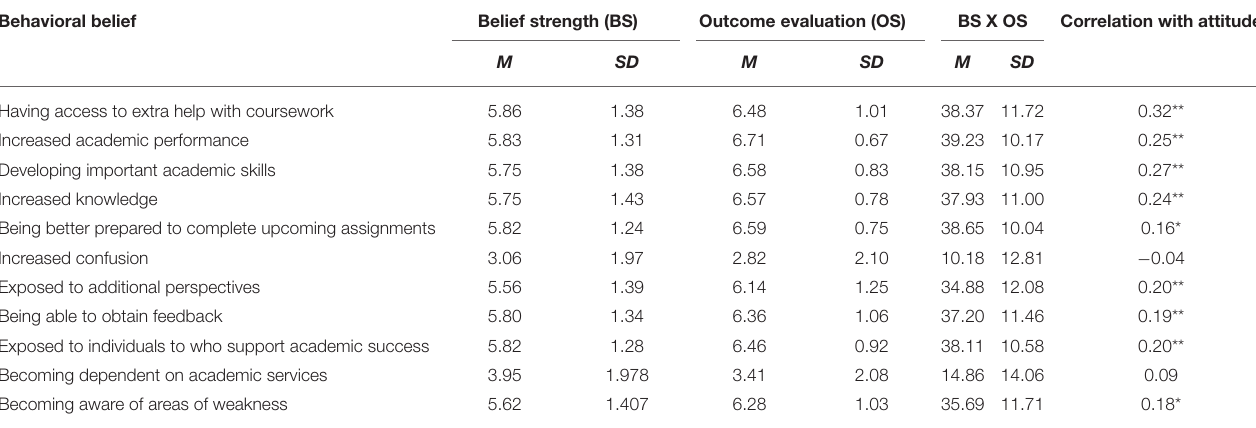
TABLE 3 | Behavioral beliefs and correlations with attitudes. Behavioral belief Belief strength (BS)